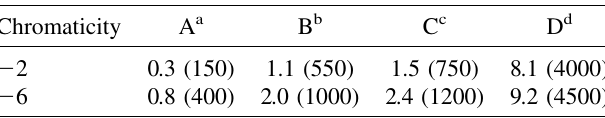
TABLE I. Achievable recycler beam density and intensity.